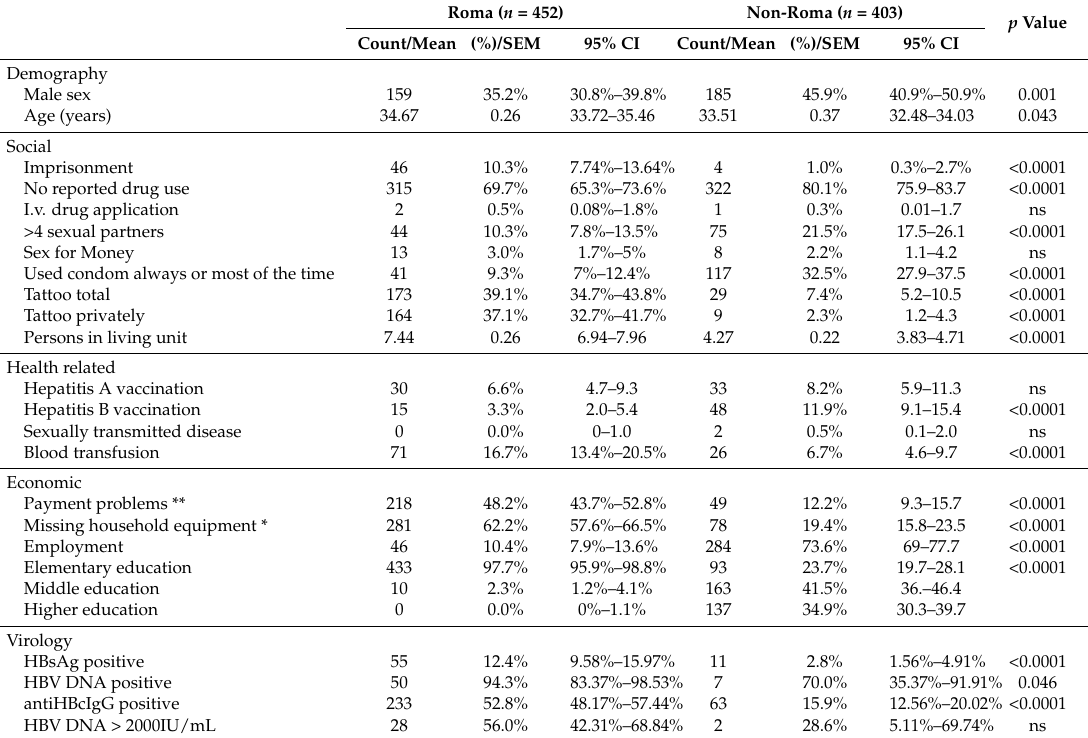
Table 1. Characterisation of the study cohort according to ethnicity. SEM—Standard error of mean, CI—Confidence interval,